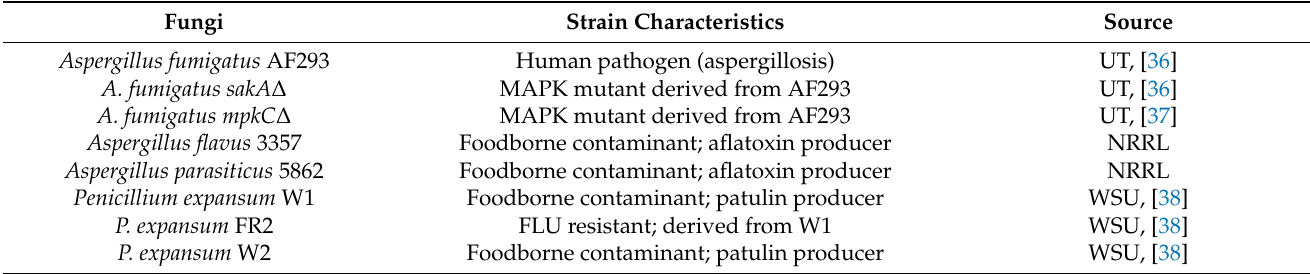
Table 1. Microbial strains used in this study 1